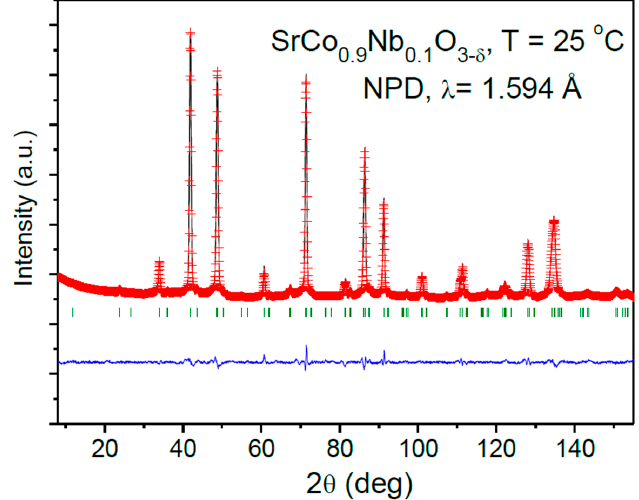
Figure 2. Observed (red crosses), calculated (black line) and difference (bottom line) neutron power diffraction (NPD) Rietveld profiles for SrCo 0.9 Nb 0.1 O 3 − δ . The series of Bragg markers corresponds to the crystallographic structure. Table 2. Unit-cell, positional, displacement parameters and selected atomic distances (Å) for SrCo 0.9 Nb 0.1 O 3 ´ δ (compared with those for SrCo 0.95 Nb 0.05 O 3 ´ δ taken from ref. [18]), reprinted and adapted from [18], with permission from © 2014 Elsevier, defined in the tetragonal P 4 / mmm (n° 123) space group, Z = 2, from neutron power diffraction (NPD) data at 25 °C.